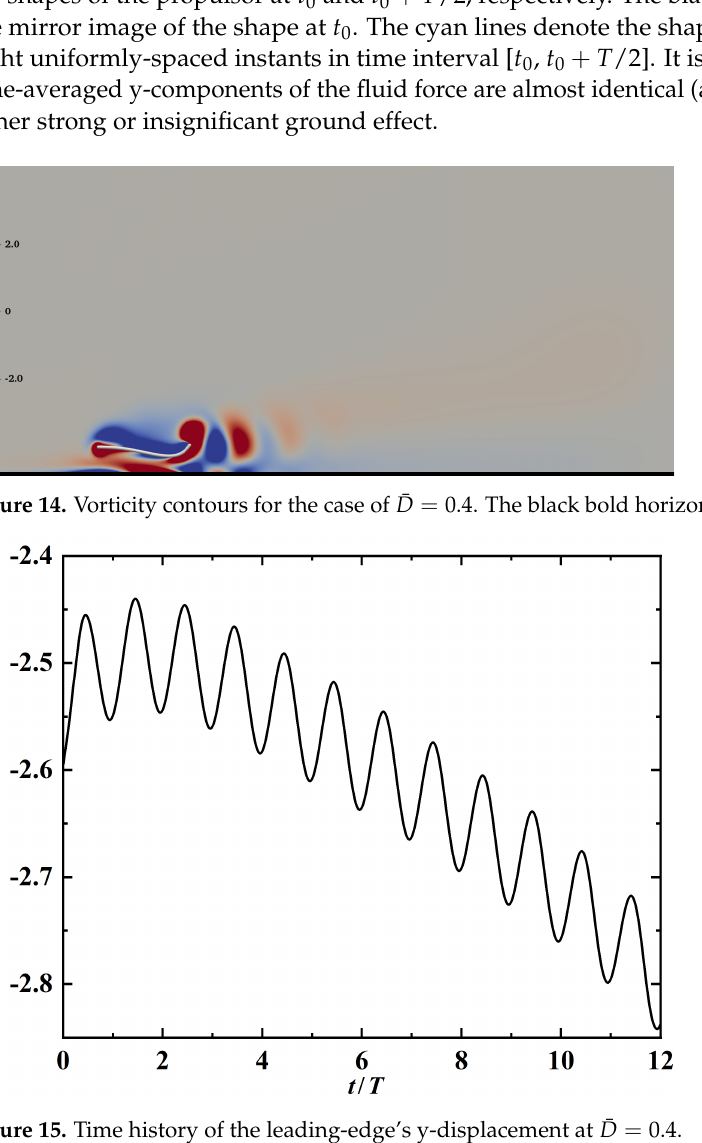
Figure 15. Time history of the leading-edge’s y-displacement at ¯ D =